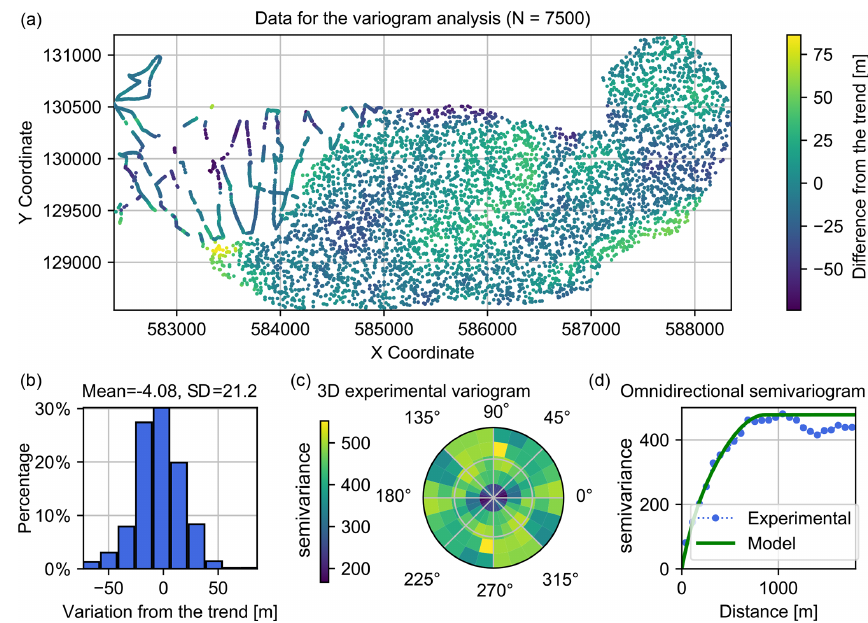
Figure 3. Variogram analysis. (a) The data set is composed of 7500 points and is assumed representative of the spatial variability of the basal topography. (b) The data set has an approximate Gaussian distribution centered around − 4 . 08m, and no transformation is applied to it. From the 2D experimental variogram map (c) , a 2D omnidirectional isotropic model is adjusted against the experimental one (d) .